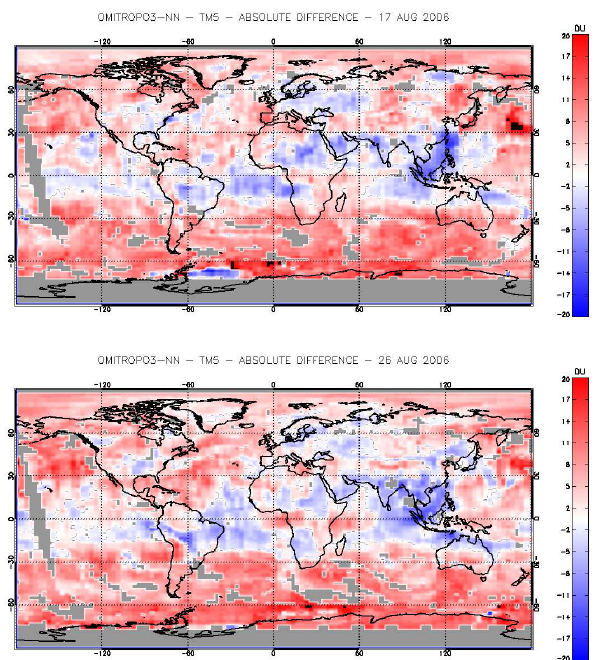
Fig. 15. Maps of the absolute differences between OMITROPO3- NN and TM5 TCO fields on 17 (top) and 26 August (bottom) 2006. The OMITROPO3-NN TCO fields are remapped on the TM5 grid.